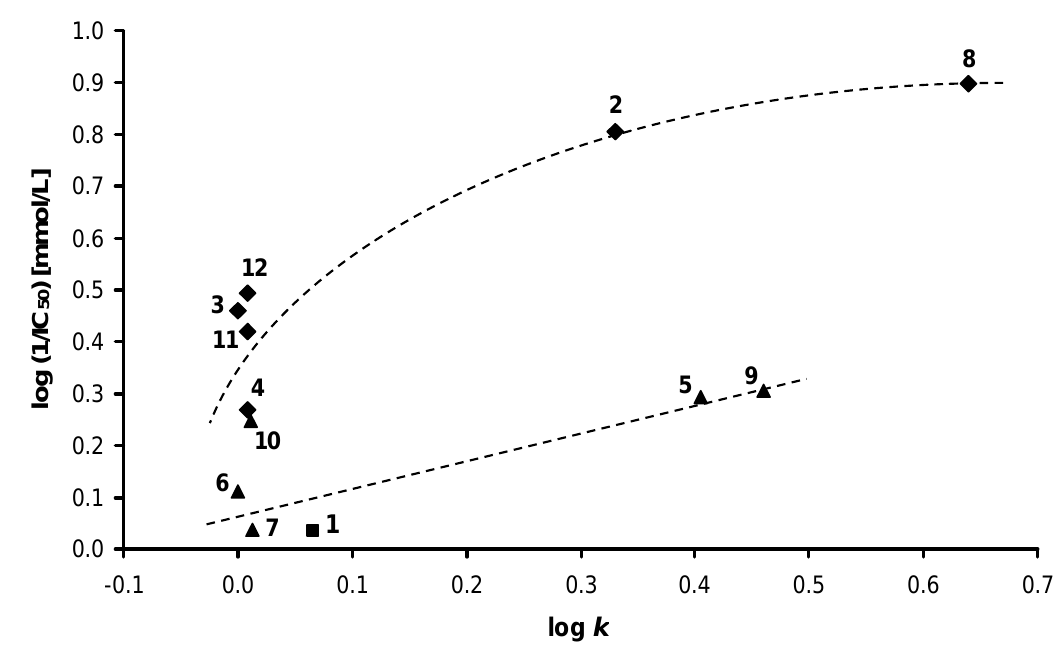
) [mmol/L] in spinach 50